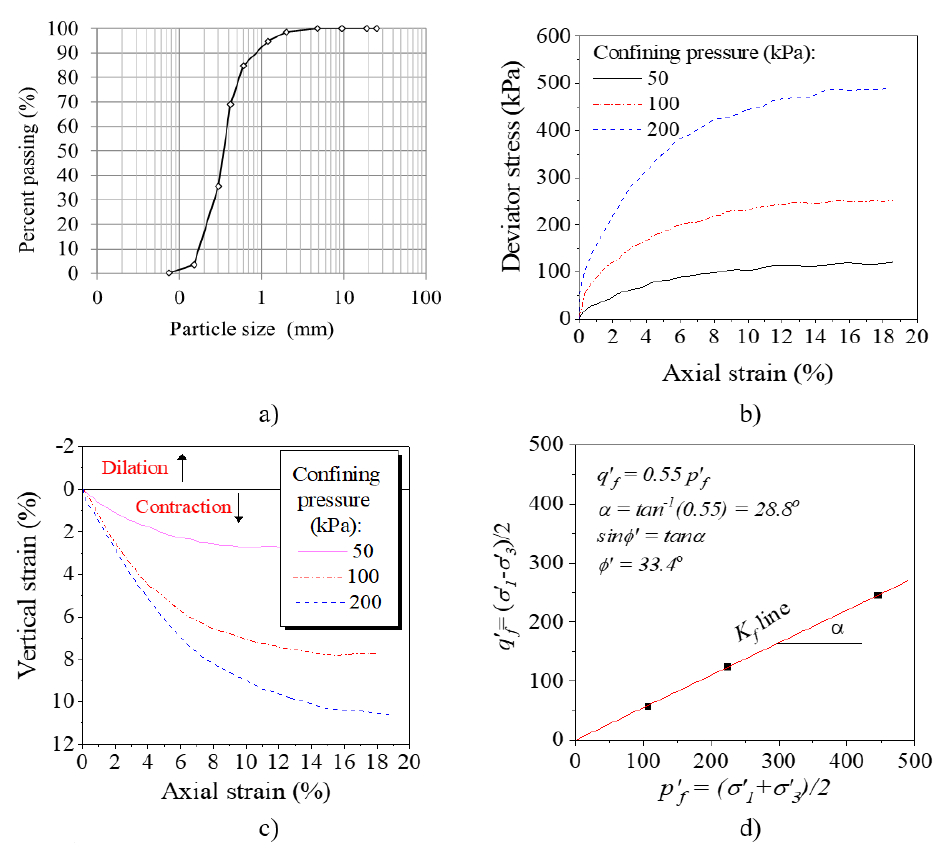
Figure 2. Properties of the backfill sand: (a) grain-size distribution; (b-c) results of CID triaxial tests performed on sand samples prepared with a relative density of 45%; (d) p-q diagram of the tested